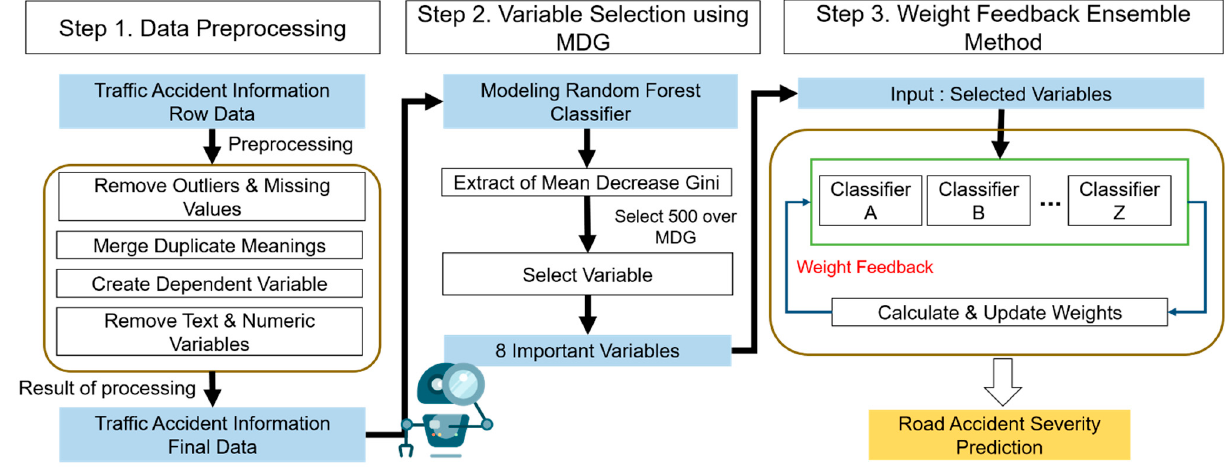
Figure 4. Weight feedback based harmonic MDG-ensemble model process for prediction of traffic accident sever- ity.